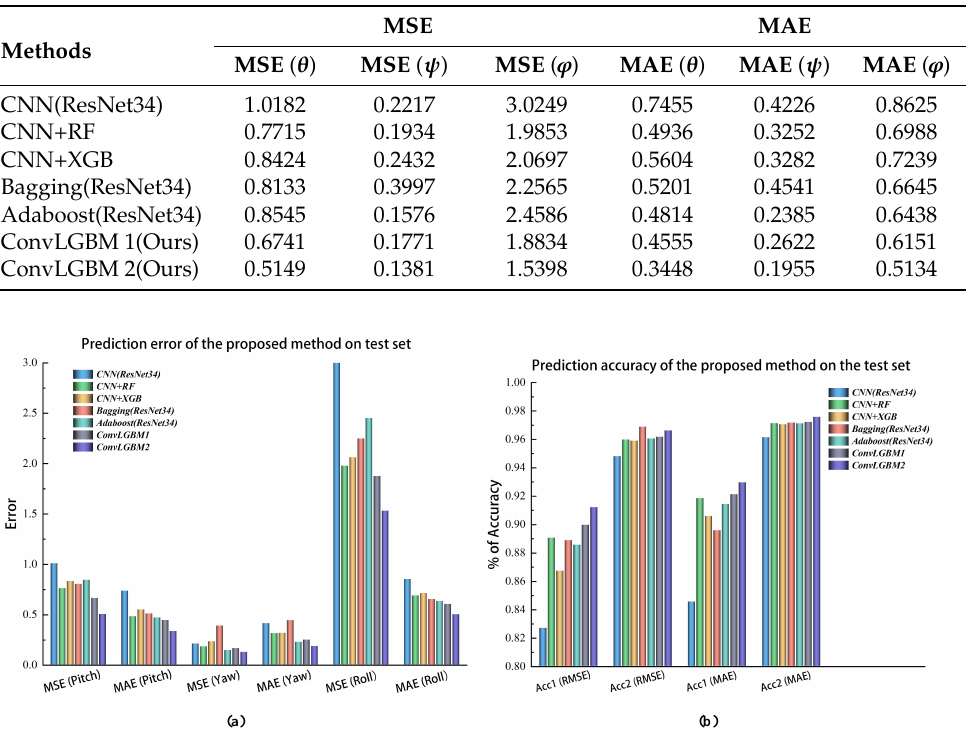
Table 5. Comparison of the proposed method to other methods.